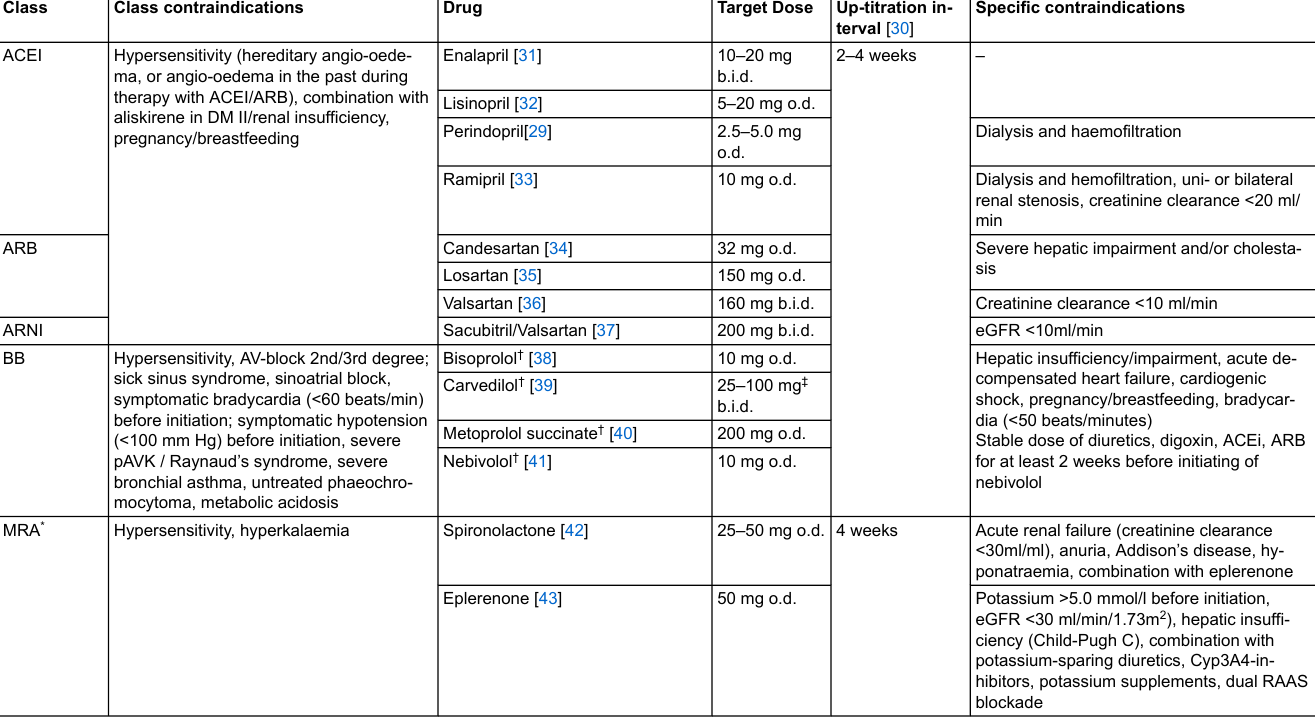
Table 2: Target doses and contraindications of common therapies for HFrEF patients, according to the Swiss Summary of Product Characteristics.